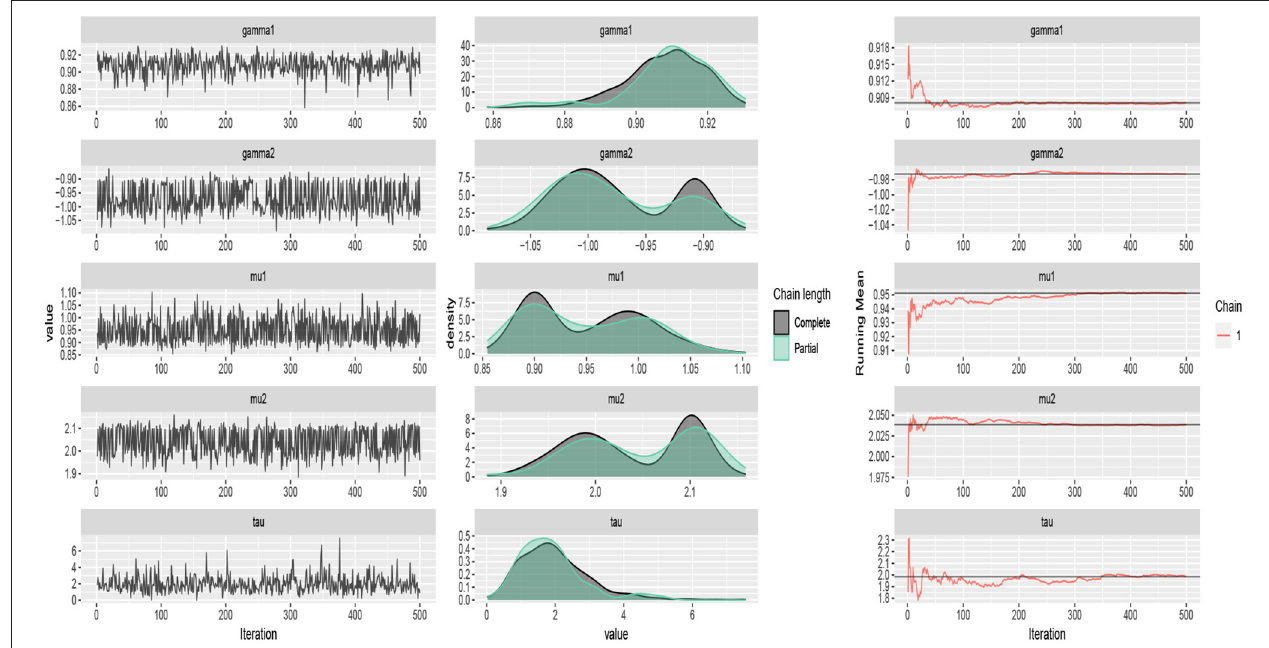
FIGURE 3 | Traceplots, mean running and estimated posterior pdf plots of generated samples for ( µ 1 , µ 2 , τ , γ 1 , γ 2 ) in Table 1 for p